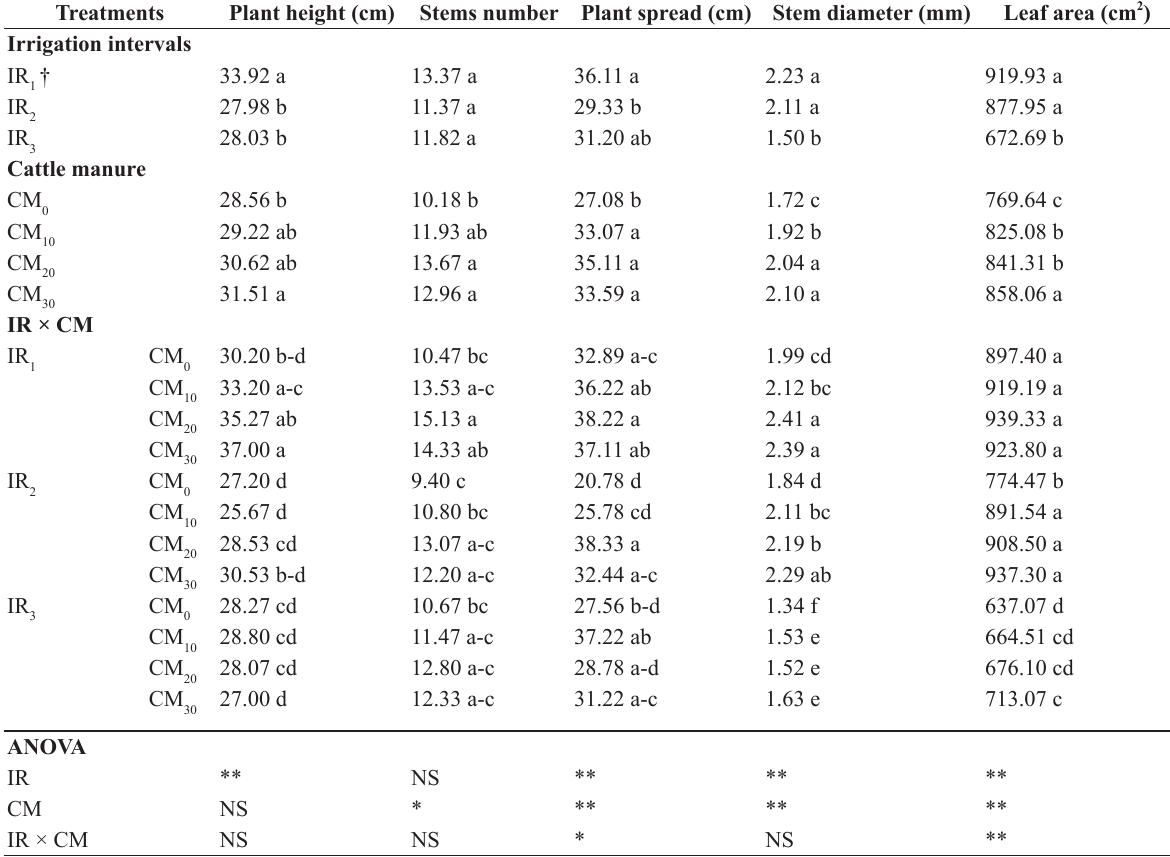
Effect of irrigation intervals, cattle manure levels and interaction of treatments on plant height, stems number, plant spread, stem diameter and leaf area in